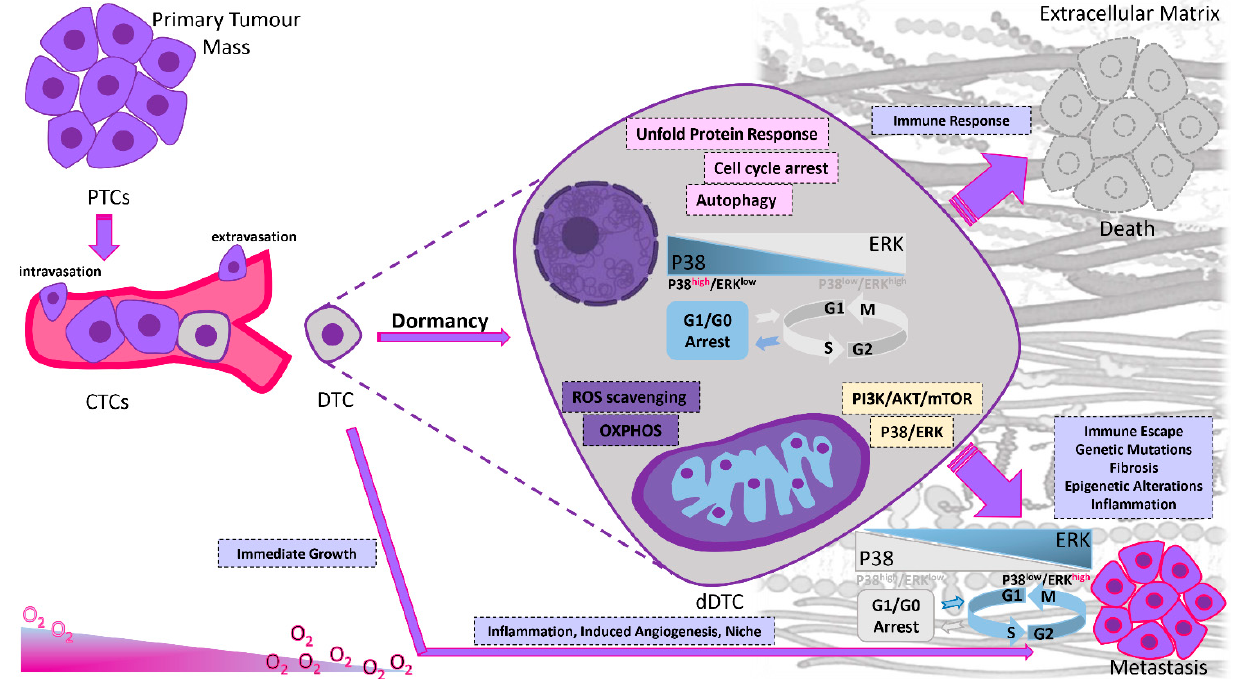
Figure 2. Dormancy in cancer progression. Primary tumor cells can leave the primary tumor site and enter the blood circulation as circulating tumor cells (CTCs). When CTCs reach a target organ, they seed into the new tissue as DTCs. Their fate is diverse depending on their cell autonomous intracellular signals and due to the local environmental signals. If DTCs fail to adapt to the new microenvironment they die due to different immune responses. If the local microenvironment can provide missing complementary cues to the DTCs, they can resume their proliferative properties. When DTCs are challenging a hostile environment may enter a dormant state due to the interactions of extracellular factors (mainly hypoxia and immune cytotoxicity) and intracellular pathways. In response to signals that are not fully elucidated but appear to involve modifications of tumor microenvironment, such as extracellular matrix remodeling, fibrosis, neovascularization, epigenetic alterations, chronic inflammation, immune escape, genetic mutations and tissue specific mechanisms in each metastatic site, tumor cells escape from dormancy, start to proliferate and ultimately form macroscopic metastases in target organs. Proliferating DTCs have to evade the immune system; otherwise, the immune system will keep them in check by preventing their expansion. The balance between activated extracellular signal-regulated kinases (ERK1/2) and activated p38 α / β has been correlated to cell dormancy in vitro and in vivo. The ERK/p38 ratio is indicative of the dormant phenotype; a high ratio induces tumor growth, whereas a low ratio promotes tumor dormancy. P38 drives a downstream program that resembles endoplasmic reticulum (ER) stress and coordinates a stress-related transcriptional program. Activation of the p38 MAPK in dormant cells induces